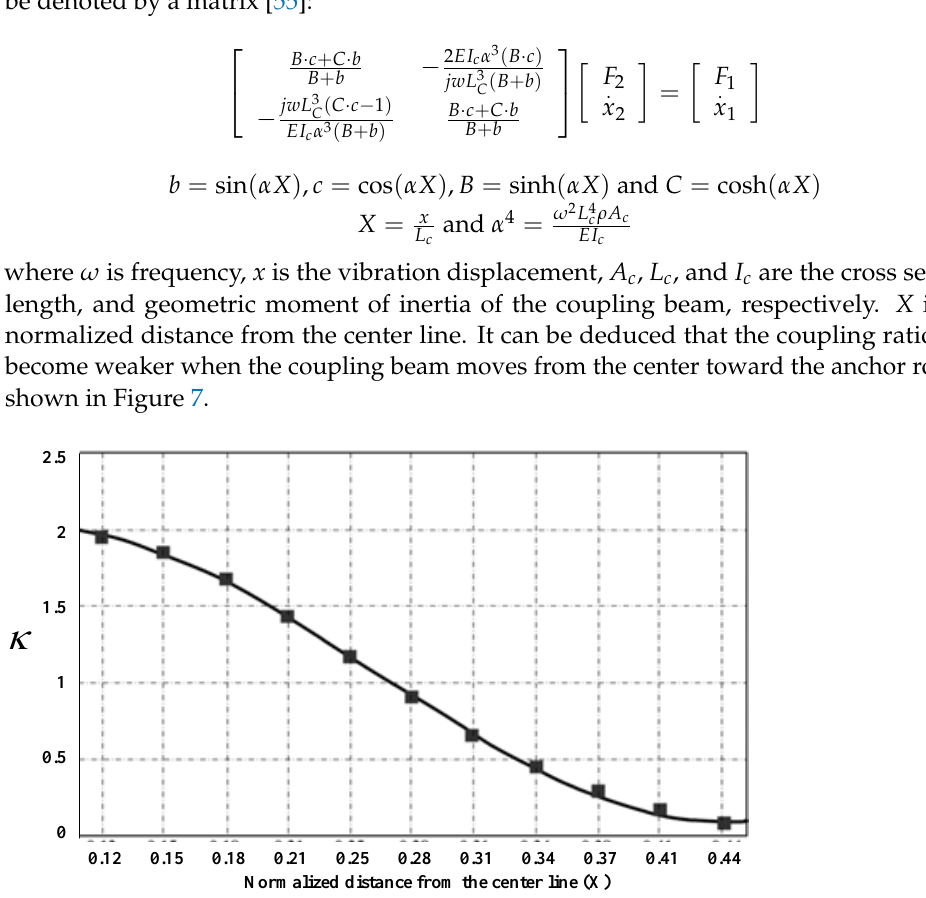
Figure 7. Coupling ratio of resonator varied with the location of beam. Reproduced with permission from [55]. Copyright © 2014 by M. Sadegh Hajhashemi.